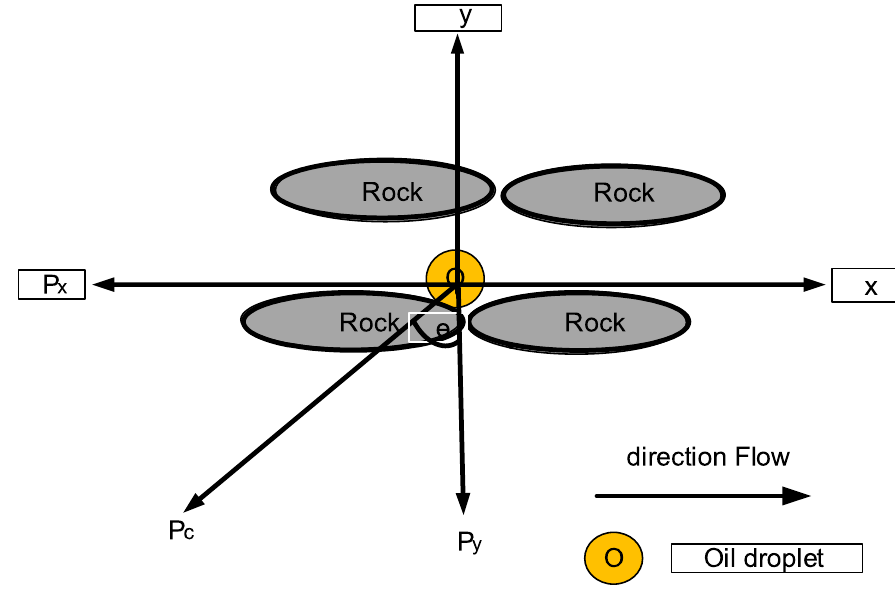
Fig. 2 Forces acting on an oil droplet located on the top of a rock surface without